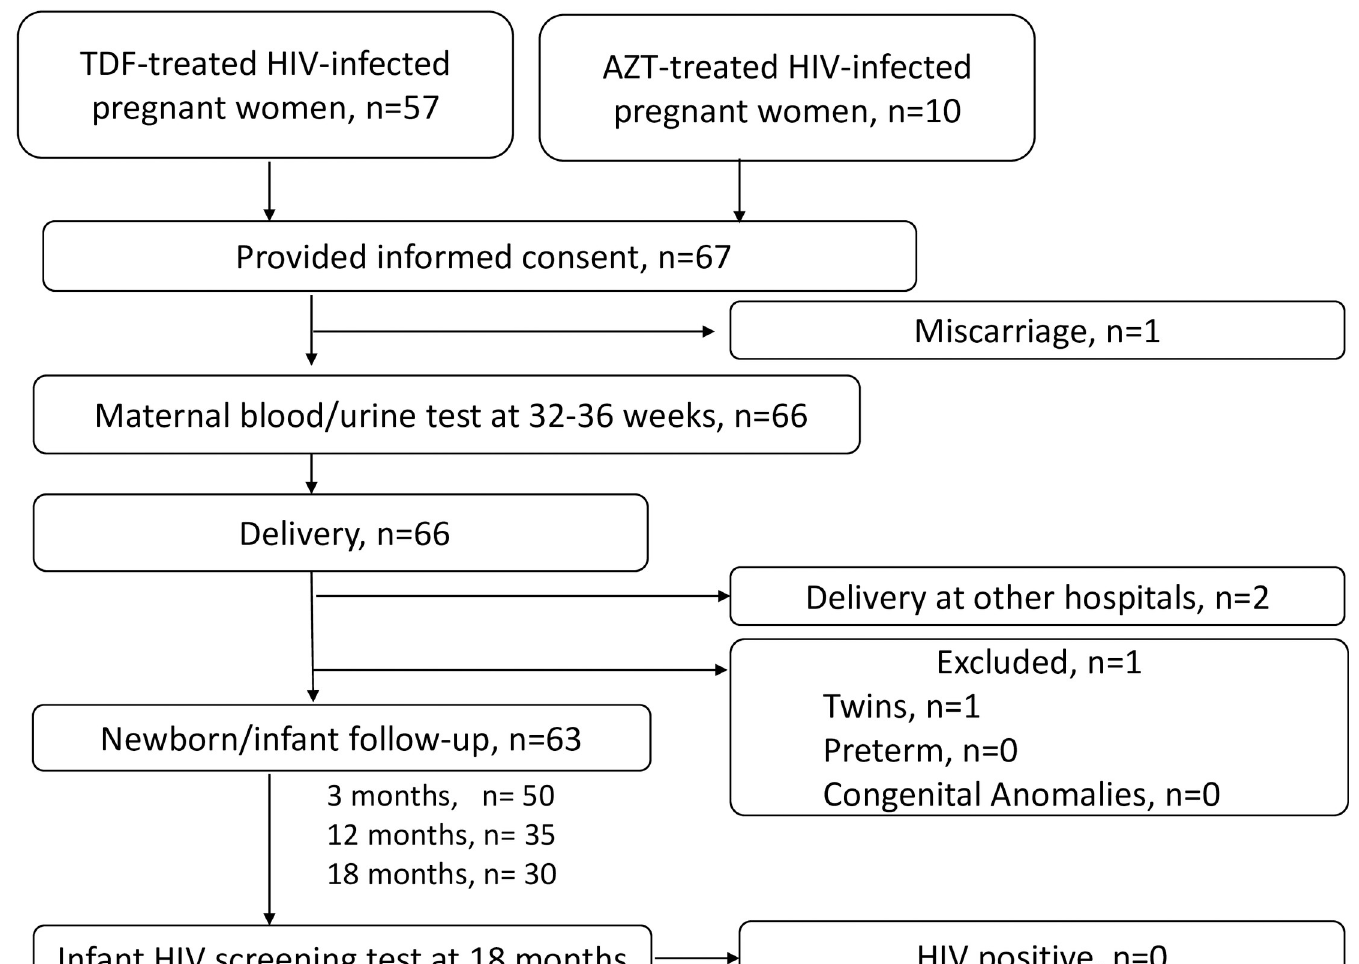
Fig 1. Flow chart of the subject enrollment process. Sixty-seven HIV-infected and 10 HIV-negative pregnant women were recruited at the NHOG. Of the 57 TDF- treated mother-infant pairs, 4 pairs were excluded due to miscarriage (n = 1), delivery at other hospitals (n = 2), and twins (n = 1). Although 3 of the 10 HIV-negative mothers were enrolled and provided maternal data and infant physical data at birth, none of the infants was brought to the center for further physical measurement and laboratory tests.